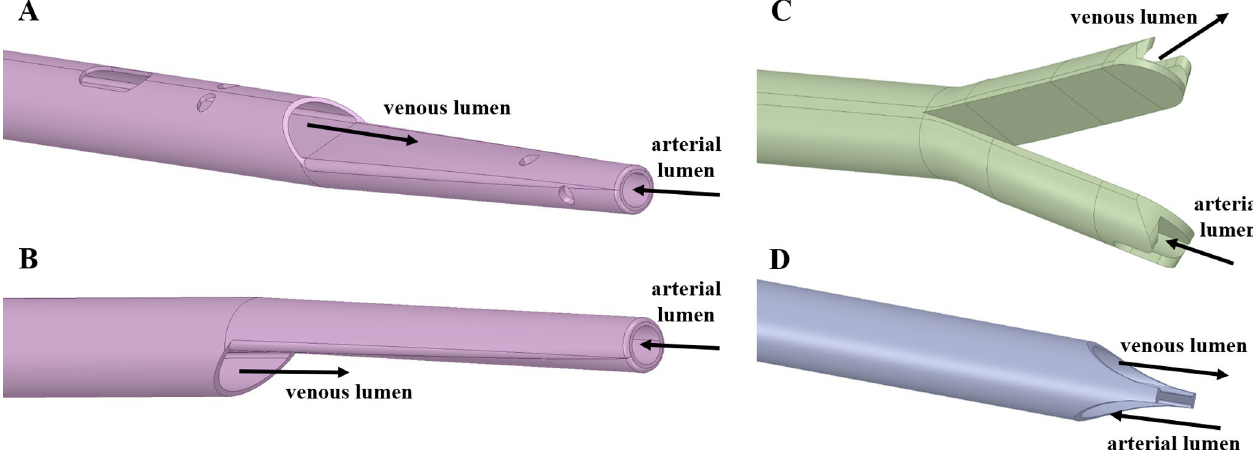
Fig 2. Catheter tip designs A, B, C and D, with arterial and venous lumens indicated. Catheters A and B were set in reverse mode (for C and D designs, forward and reverse mode lead to the same model configuration).